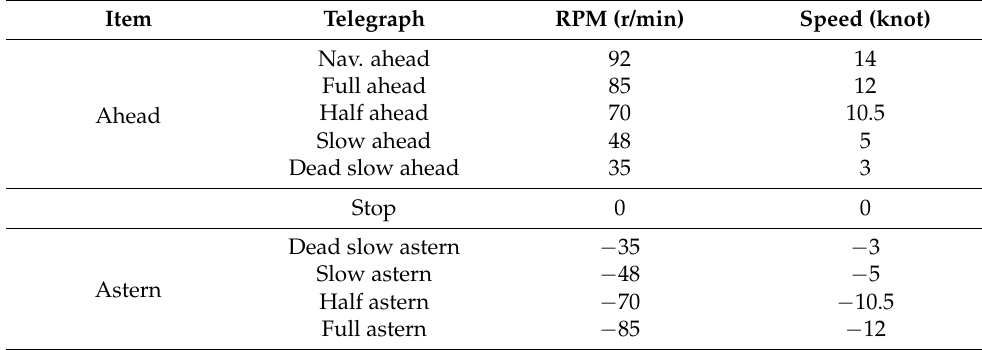
Table 1. Propulsion particulars about RPM and speed of ship “Huayang dream”.